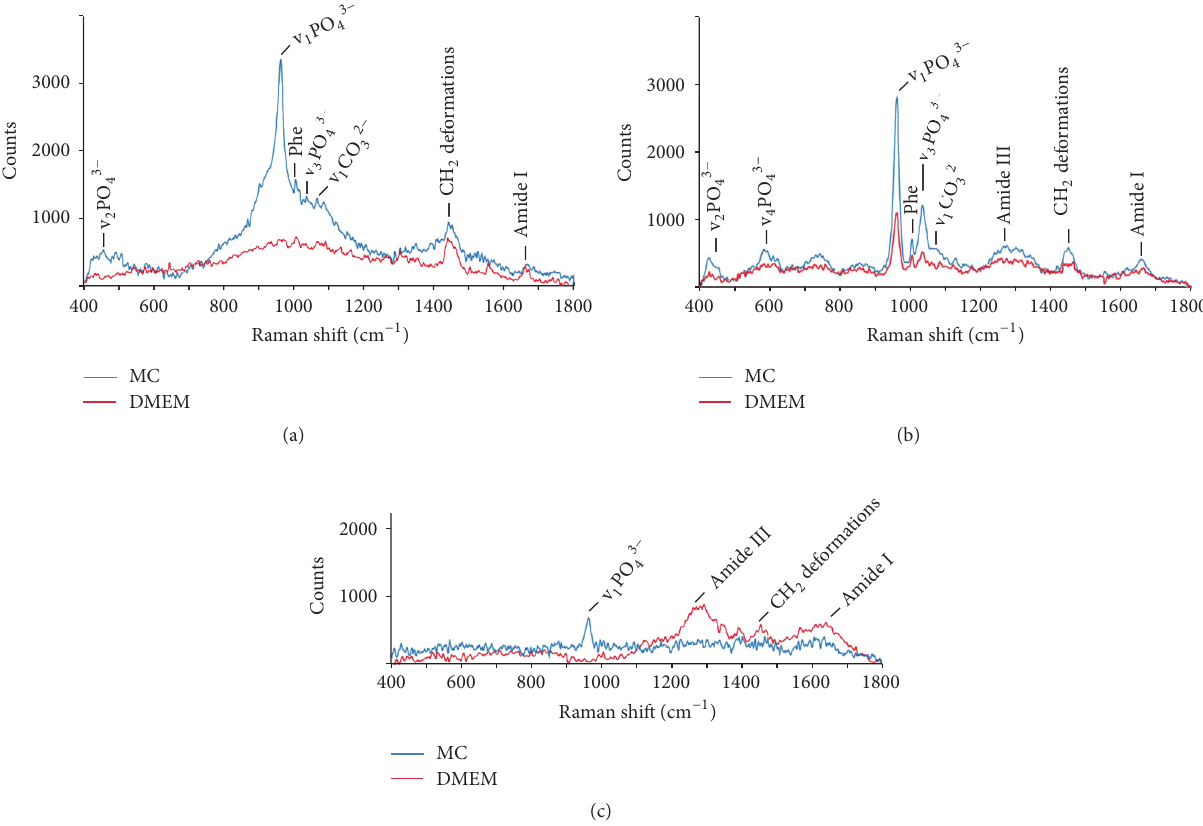
Figure 2: Mean Raman spectra collected from MSCA-1 + JPCs after 20 days of osteogenic differentiation in DMEM and MC medium. (a) Spectra from patient #1: averages were generated from 79 (MC) and 48 (DMEM) single spectra; (b) 128 (MC) and 37 (DMEM) single spectra were averaged for mean spectra from patient #2; (c) mean spectra from patient #3 were generated from 46 (MC) and 100 (DMEM) single spectra. Bone-specific peaks were assigned based on Mandair and Morris (2015)